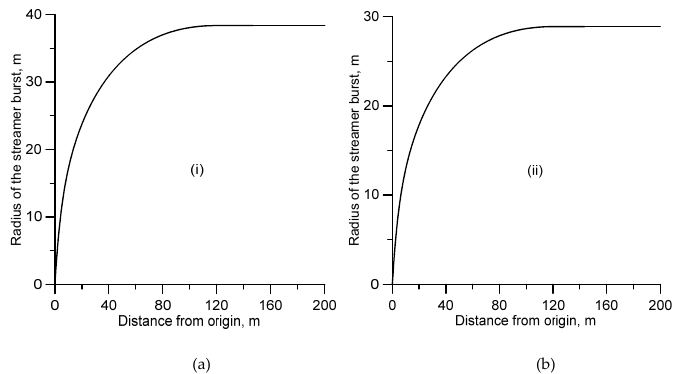
Figure 10 . The lateral growth of the streamer burst as a function of distance obtained for the two cases ( a ) and ( b ) presented in Figure 8.